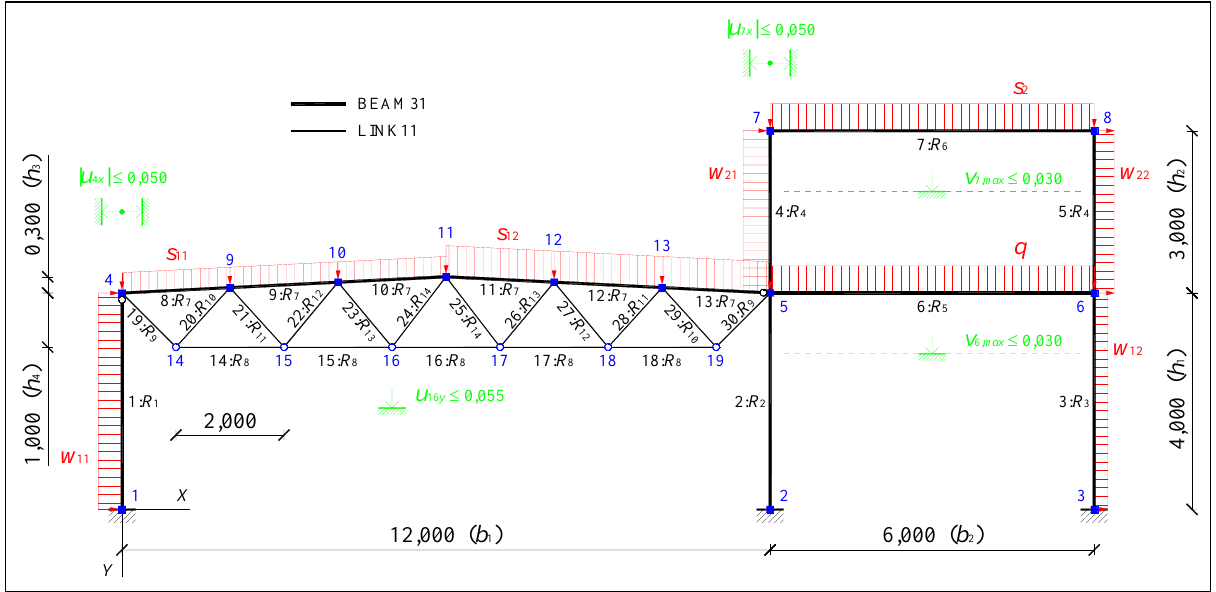
Fig. 21. Structural model discretized by LINK11 and BEAM31 finite elements